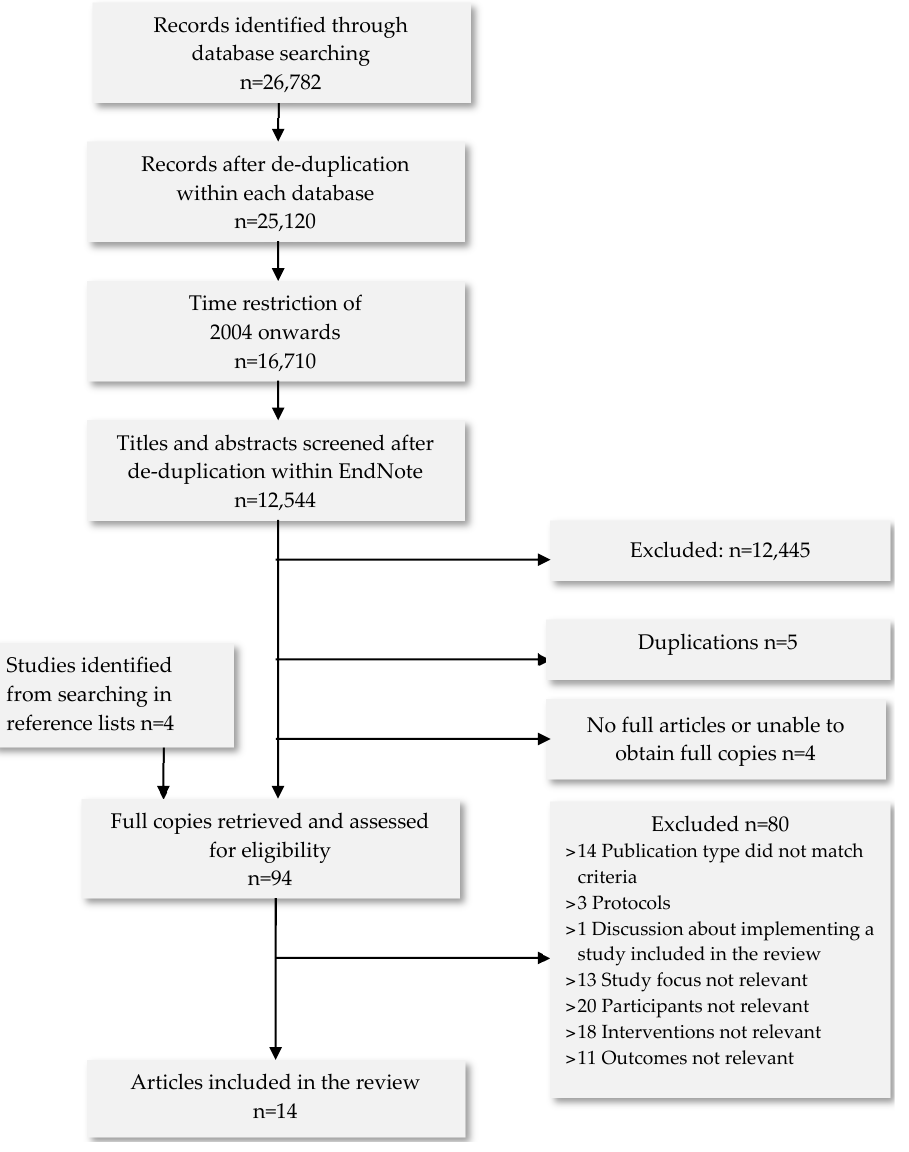
Figure 1. Flow diagram for the identification of eligible studies. (Only one reason is given per excluded study although in many cases reasons for exclusion were more than singular.) Table 1. Studies included in the